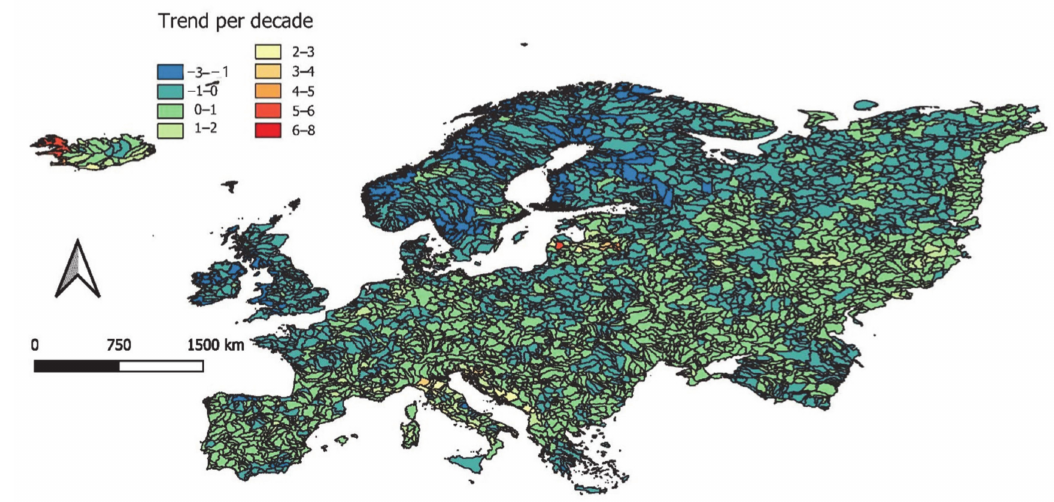
Figure 4. Changes in the mean annual number of days with a compound occurrence of drought and extreme heat in the 1961–2018 period. Results for the basic case and N = 365 days are